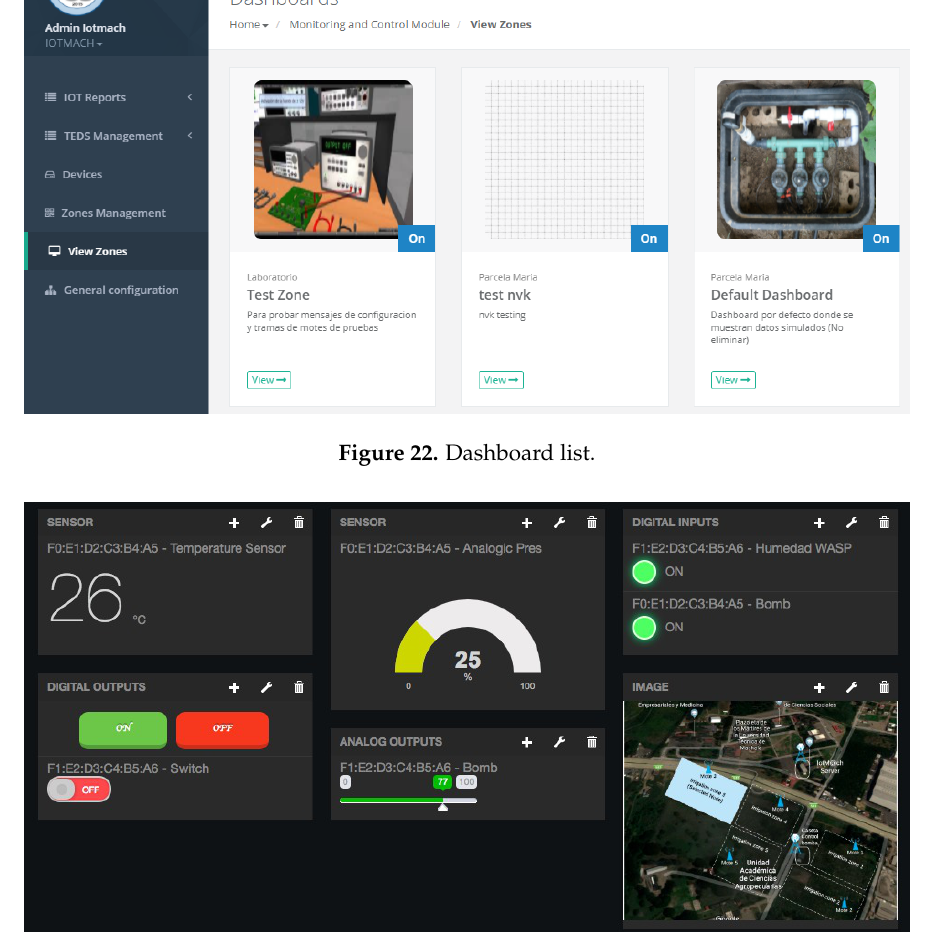
Figure 23. Example of a real-time